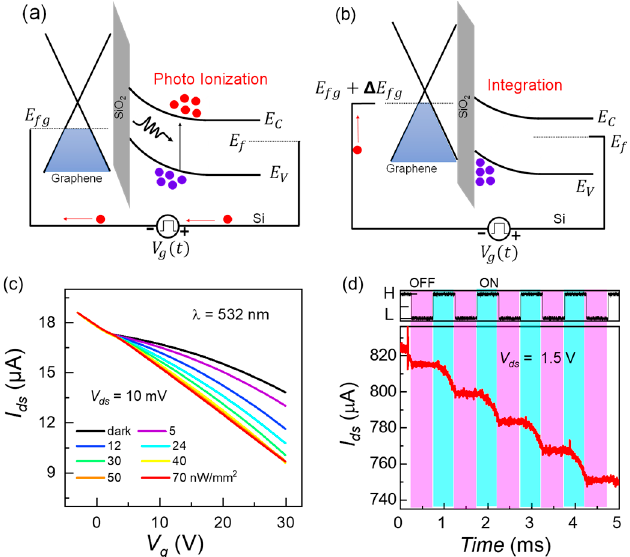
Figure 2. ( a ) Energy band diagram showing the photoionization process in the space charge region; it is equally valid for a constant or pulsed laser illumination. ( b ) This energy band diagram expresses that electrons drift into the bulk silicon and holes integrate at the Si/SiO 2 interface, causing a change in graphene’s Fermi level ( ∆ E fg ). ( c ) The quasi-static I ds − V g curves for multiple constant exposures of 532 nm wavelength laser. ( d ) The capability of the GCCD pixel for photo-sensing and multi-logic memory applications is illustrated using I ds . For a square gate bias V g = 33 V, V ds = 1.5 V, and 532 nm laser pulses, charge integration can be monitored in real time by I ds − t